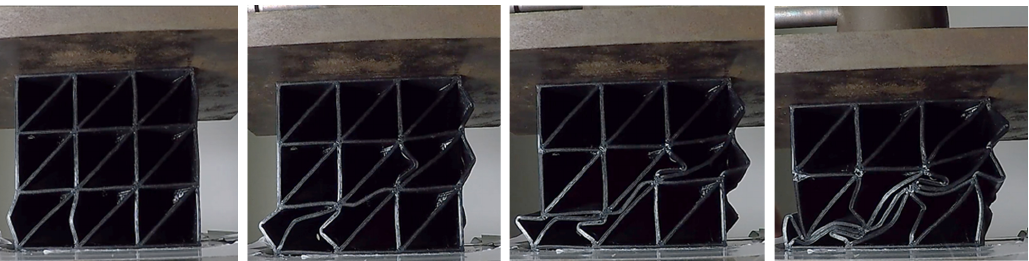
Figure 19. Experimentally-observed deformation sequence of one representative large-scale novel honeycomb sample under lateral load.